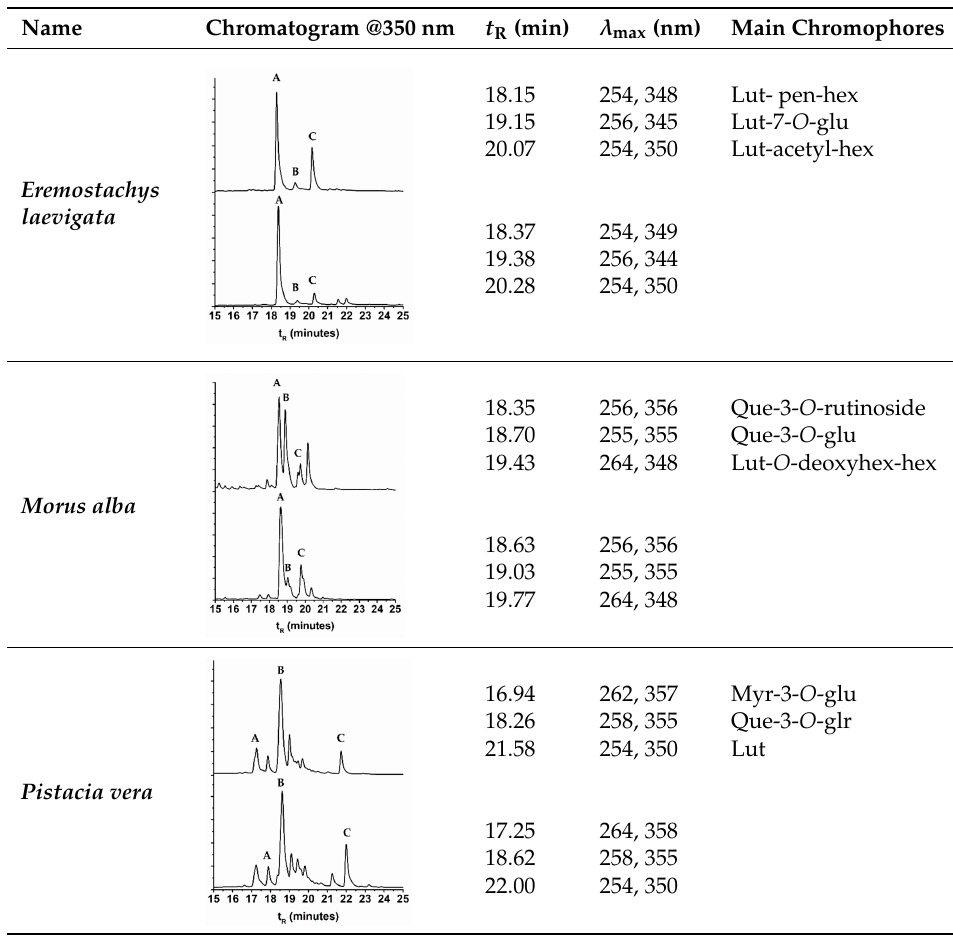
Table 4. HPLC-DAD profiles for the extracts of the plant (up) and dyed wool (down) for Eremostachys laevigata, Morus alba , and Pistacia vera. The retention times, t R , for the main chromatographic peaks are given together with the wavelengths of the main absorption bands.